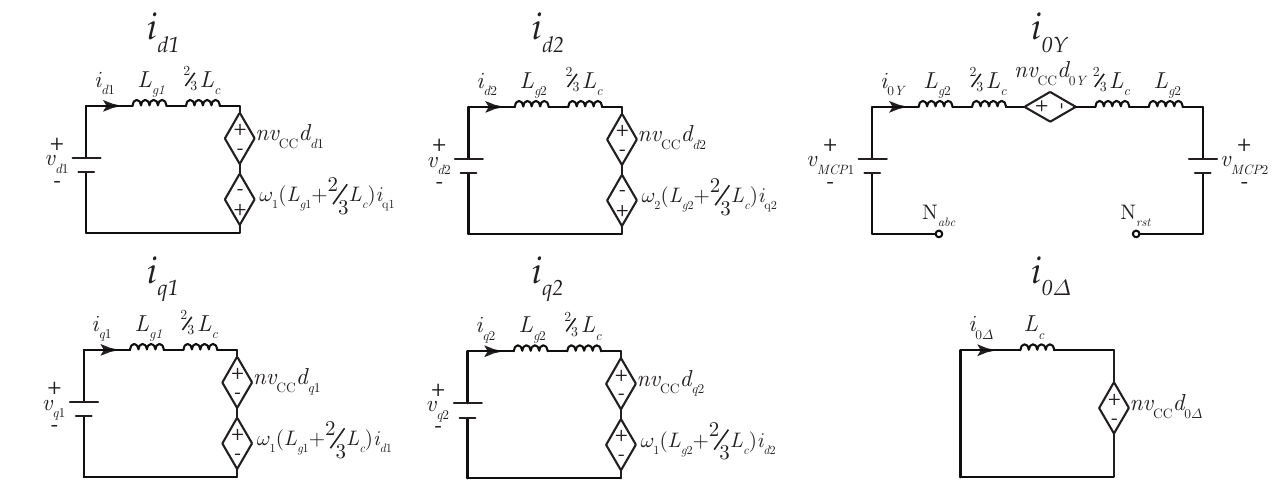
Figure 3. Equivalent circuit for the converter currents in dq